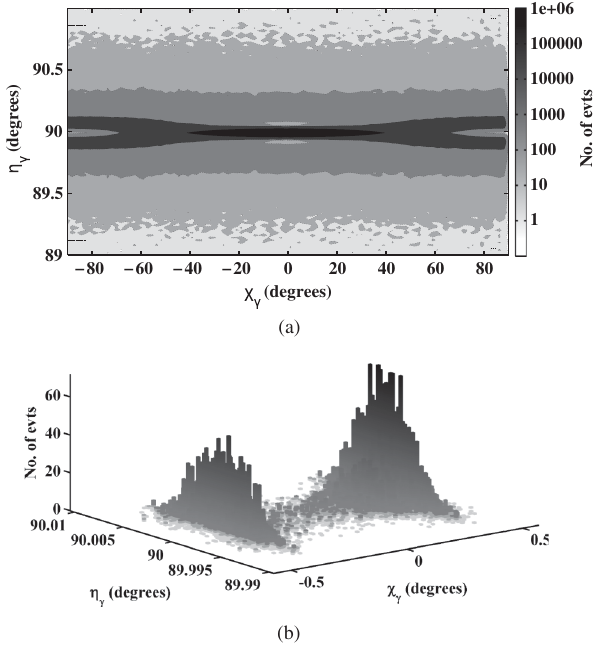
FIG. 19. (a) The angular distribution of the azimuthal angle η γ and polar angle χ γ of the electric vector of the γ rays produced by Compton interactions without energy selection. (b) The same angular distribution but for γ rays energy above 0 . 99 E max